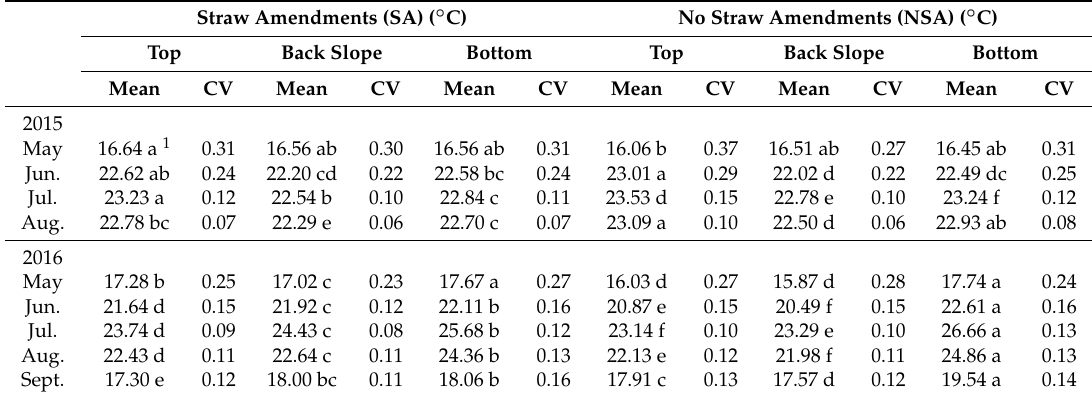
Table 3. Monthly soil temperature in the treatments with straw amendments (SA) and without straw amendments (NSA) in 2015 and 2016 ( n = 1448).